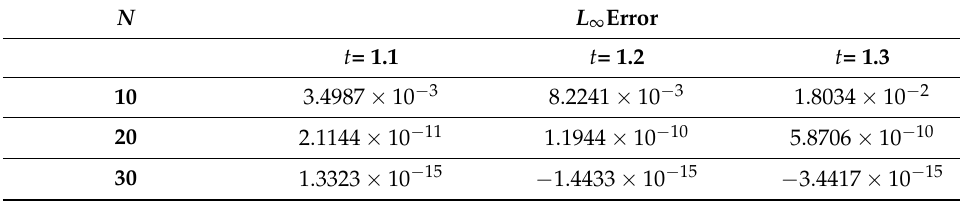
Table 6. Error analysis regarding Example 5.